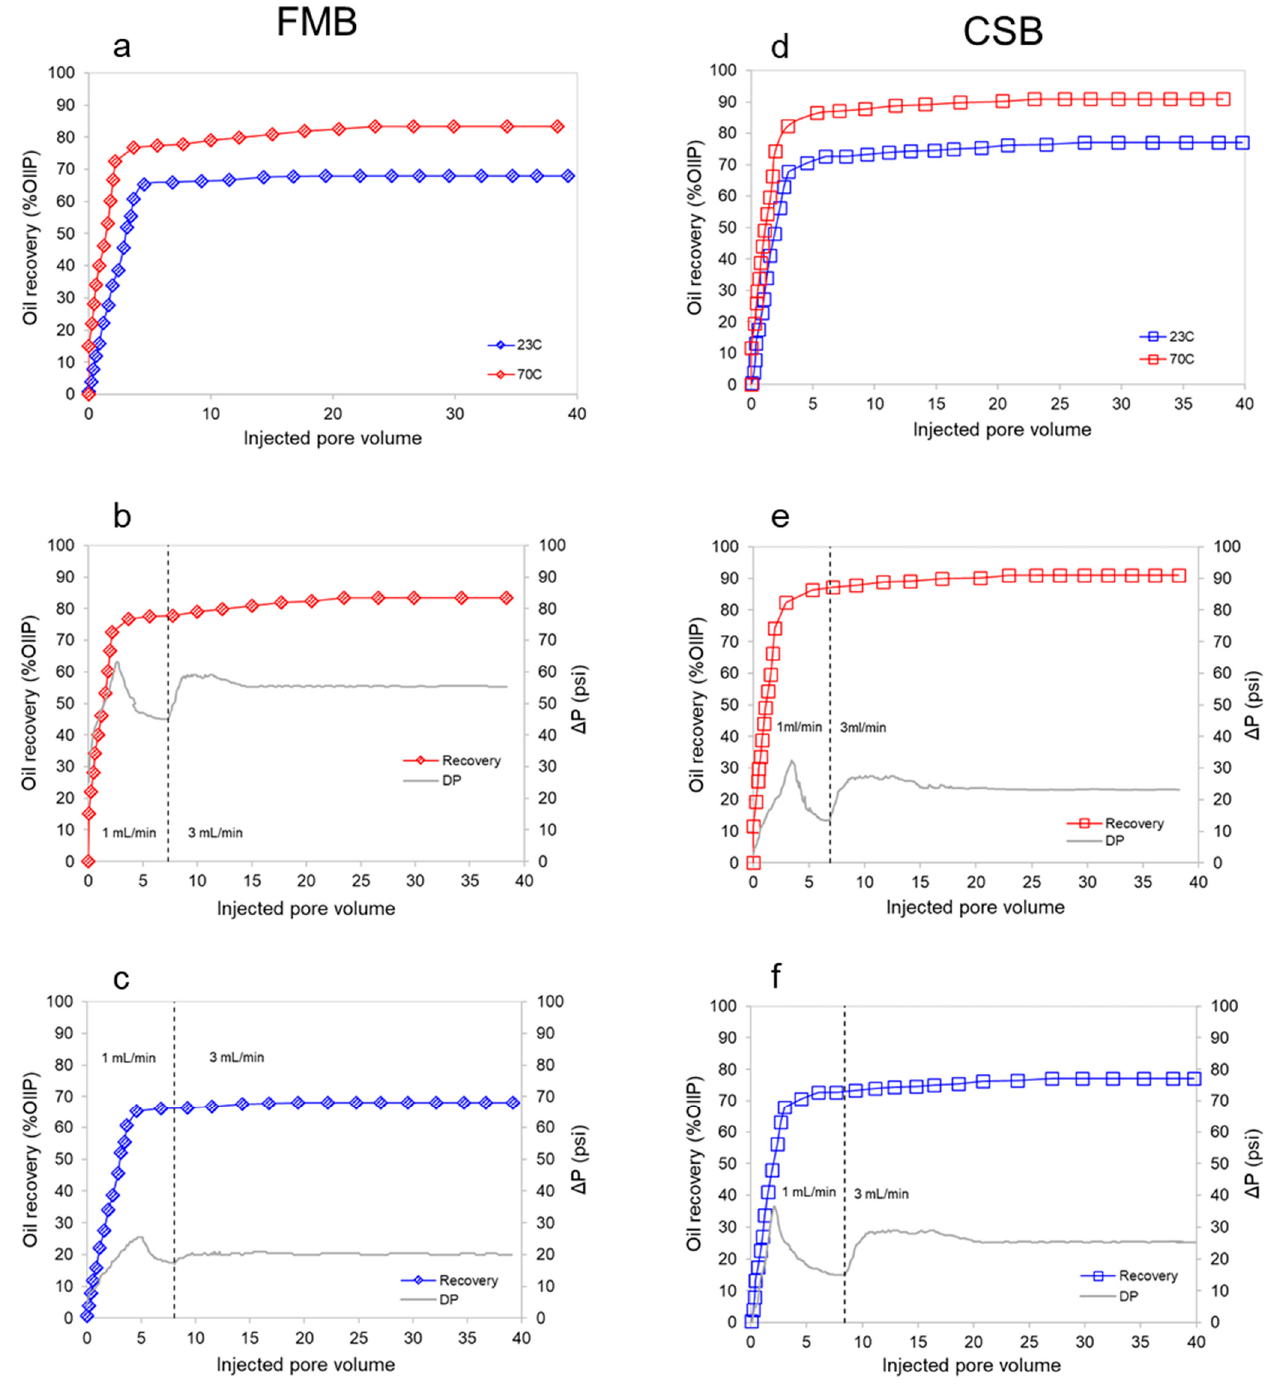
Figure 2. Oil recovery during secondary injection of FMB ( a – c ) and CSB ( d – f ). Red diamonds ( a , b ) correspond to waterflooding experiments carried out at 70 ◦ C on rock sample C29 with initial water saturation of S wi = 0.32, while blue diamonds ( a , c ) correspond to the experiments at 23 ◦ C on rock sample C30 with S wi = 0.31. Red squares ( d , e ) correspond to waterflooding carried out at 70 ◦ C on sample C27 at S wi = 0.37, while blue squares ( d , f ) represent the results obtained with C26 at 23 ◦ C and with S wi = 0.39. Grey curves show the measured pressure difference across the samples and vertical dashed lines indicate a transition from the injection rate of 1 mL/min to 3 mL/min. The ultimate oil recovery of 77.08% OIIP was obtained in the experiment carried out at 23 ◦ C with CSB, while the ultimate oil recovery of 90.96% OIIP was obtained at 70 ◦ C. For the 23 ◦ C CSB core flooding experiment, oil recovery ceases at approximately